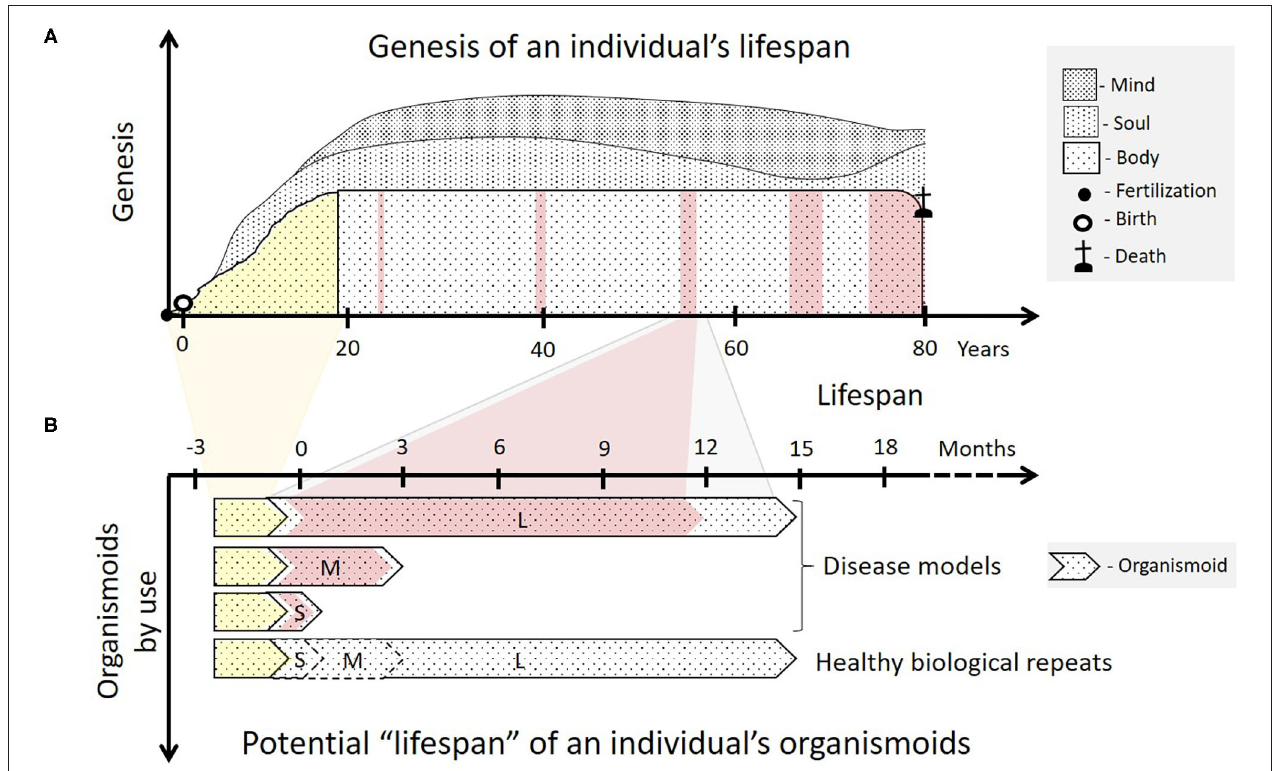
FIGURE 1 | Organismoids in the context of each human individual’s fate. (A) The ontogeny (yellow) of an individual’s body begins with ovum fertilization, followed by birth and ends with sexual maturity, a fully functional brain and an adult skeleton after 18 to 20 years. The adult body then goes through a lifelong period of relatively functional and architectural homeostasis lasting many decades. This adulthood is interrupted with increasing frequency by periods of ever-prolonging illness and recovery as the body ages (pink). Emotions and consciousness—the soul and the mind of a human being—begin to develop consecutively in childhood and continue to do so throughout life (sociogenesis). (B) According to the organismoid theory, personalized organismoids can be established through accelerated in vitro ontogenesis (yellow) lasting a few months. The resulting adult organismoids can then emulate a certain stage of healthy human adulthood for weeks (S—short-term), months (M—mid-term) or years (L—long-term), depending on use. These can then be utilized to emulate acute, sub-chronic and chronic disease periods (pink) and therapy-based recovery of an individual within the respective time frame. A large number of identical organismoids ensure that a sufficient number of healthy biological repeats can be run simultaneously serving as controls for full recovery of the diseased organismoids by a precision medicine or advanced therapy approach. Moreover, such healthy organismoids are useful to evaluate preventive medicine approaches, such as vaccination for the respective